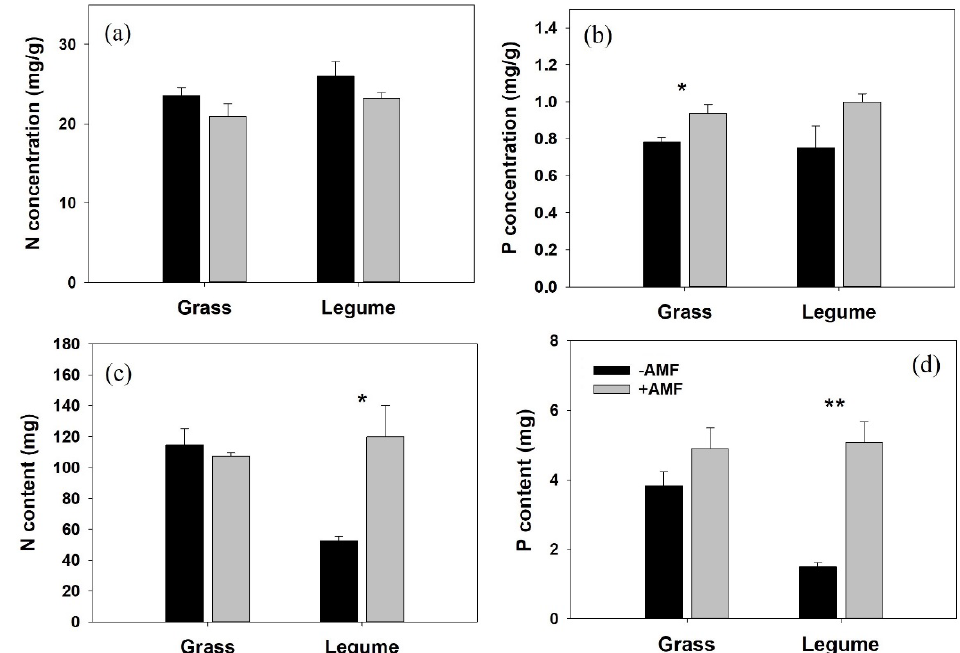
Figure 3. Nitrogen (N, ( a )) and phosphorus (P, ( b )) concentrations (mg/g) and contents (mg per plant, N, ( c ) and P, ( d )) in shoots of Elymus nutans (Grass) and Trifolium repens (Legume). Data are presented as the mean ± standard error of three replicated pots. Significant differences (as determined by t test) between mycorrhizal (gray bars) and nonmycorrhizal (black bars) treatments are indicated by asterisks (* p < 0.05, ** p < 0.01).